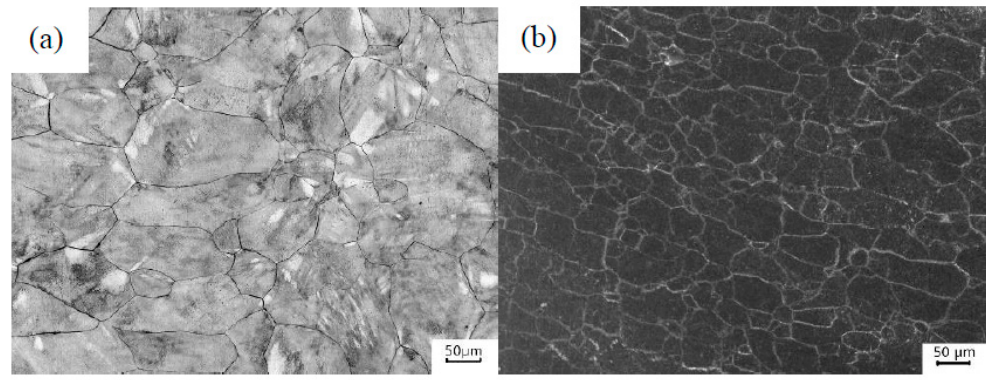
Figure 4. ( a ) The welded and ( b ) forged welded joints of Ti600/Ti-22Al-25Nb.